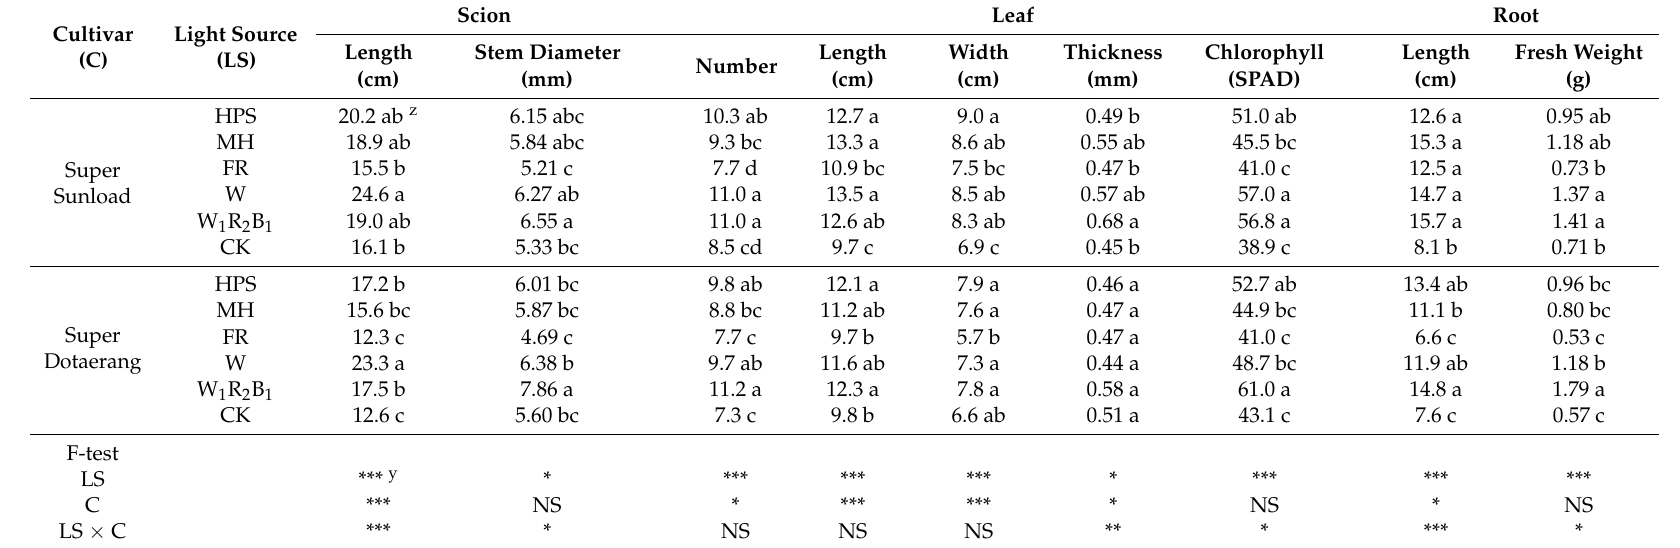
Table 1. Effects of 10-day supplementary light treatments on growth and development of grafted tomato